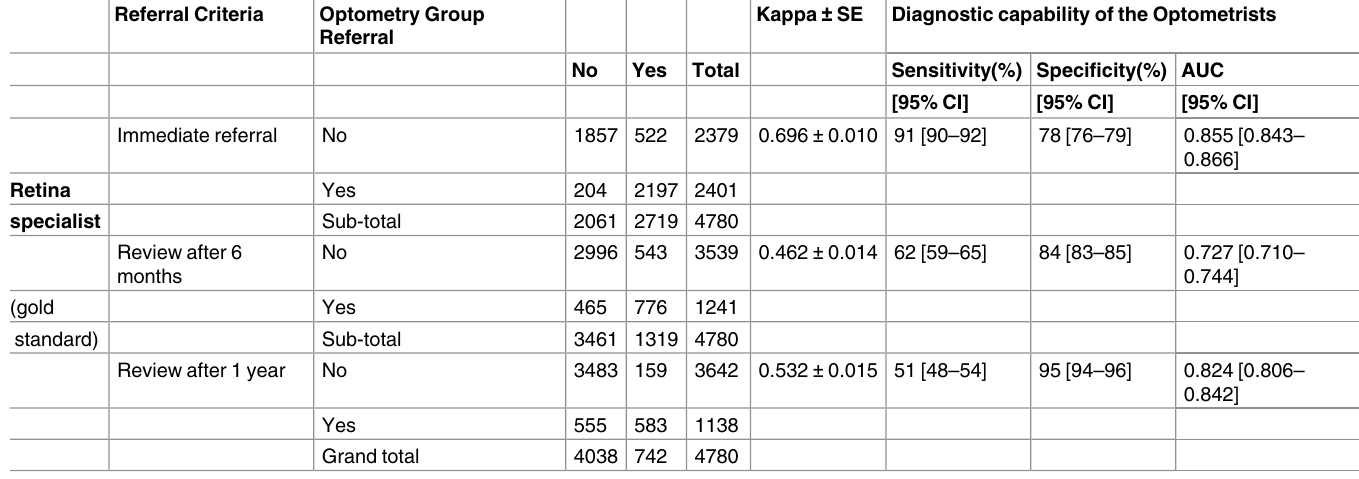
Table 2. The Number of Correct and Misclassified Images in Each Referral Type and the Agreement Between Optometrists Versus Retina